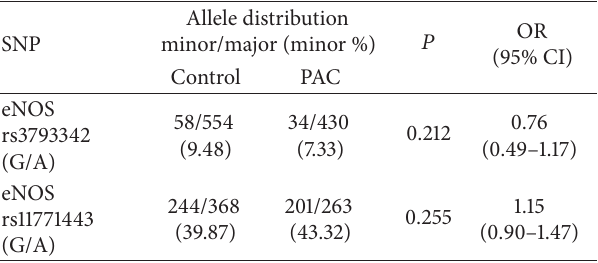
Table 3: Allele frequency of SNPs in control and PAC